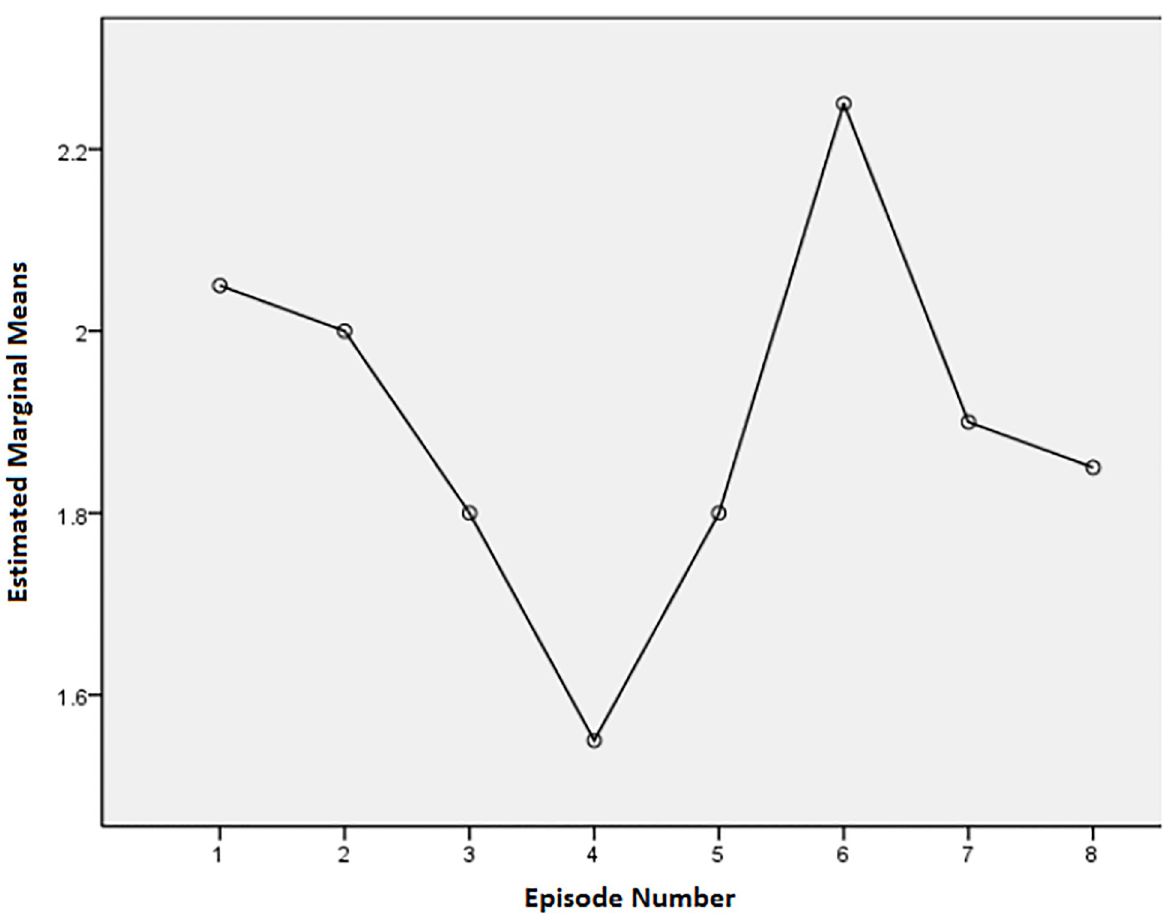
Fig 2. Means plot for enjoyment of the AD ratings (1 is very enjoyable and 5 is not enjoyable at all).